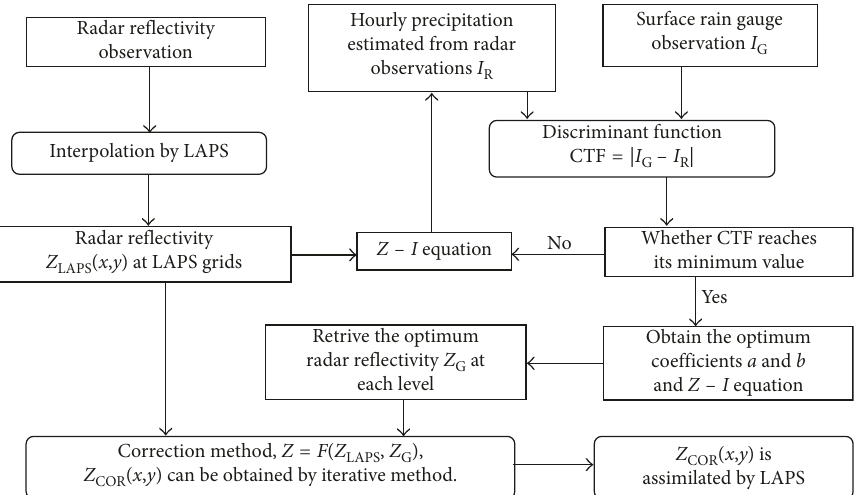
Figure 2: Diagram of the correction method to correct radar reflectivity using hourly surface rain gauge